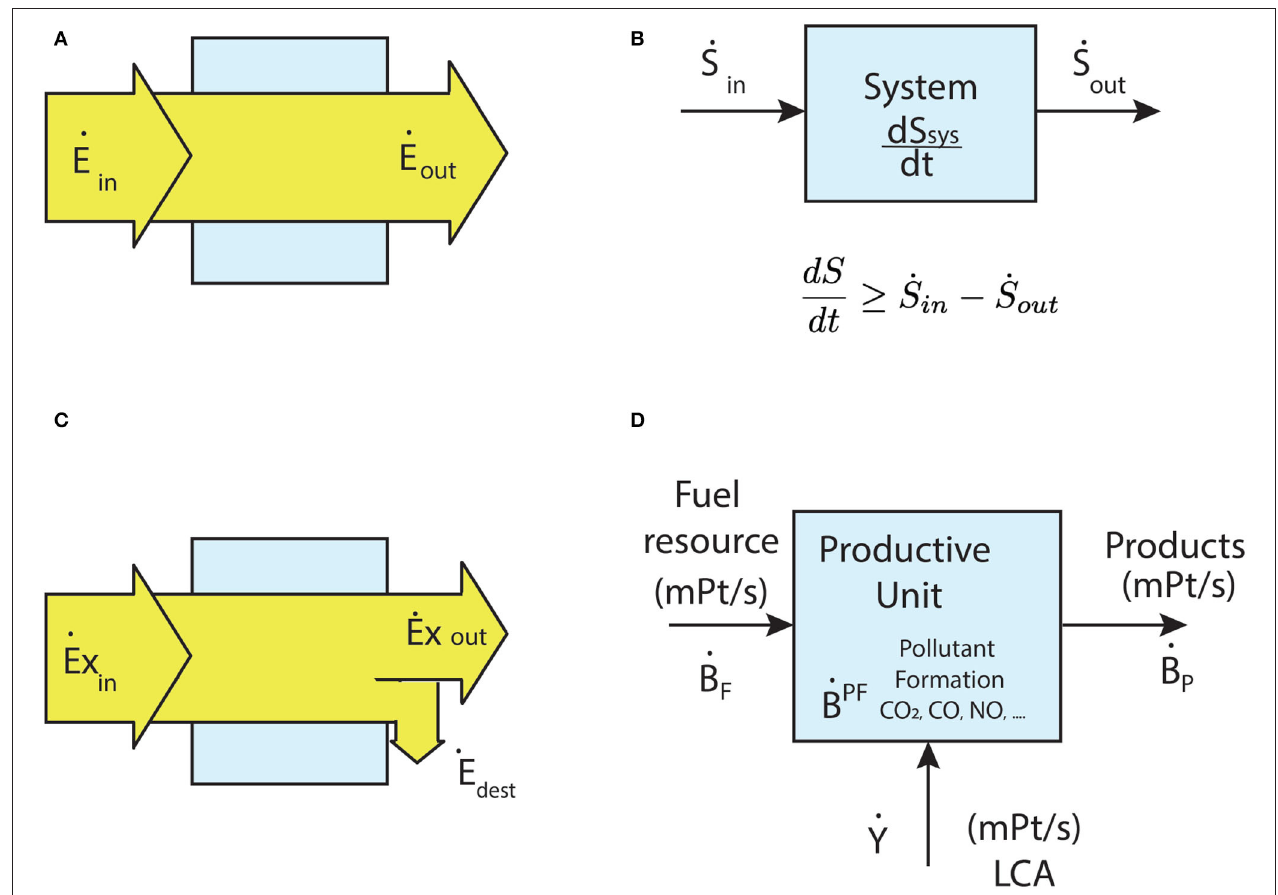
FIGURE 1 | (A) Energy balance under steady-state process; (B) System entropy change and entropy transfers; (C) Illustration of exergy destruction in a process; (D) Exergoenvironmental balance of productive unit based on SPECO approach.